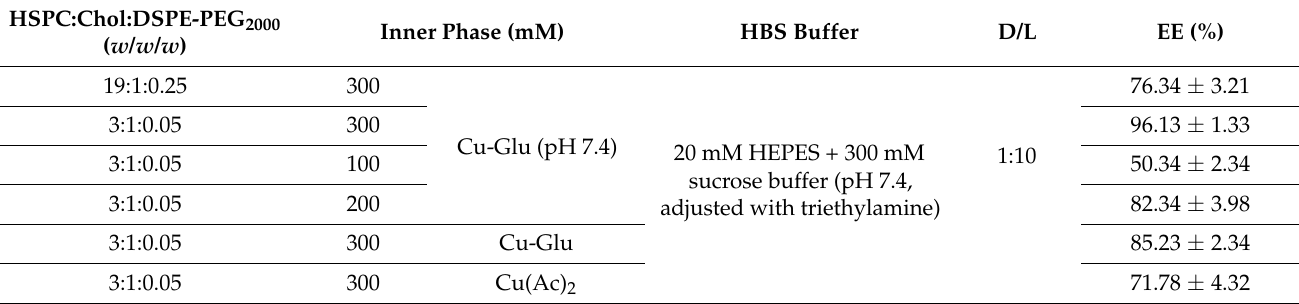
Table 3. Encapsulation efficiency of copper ion gradients.